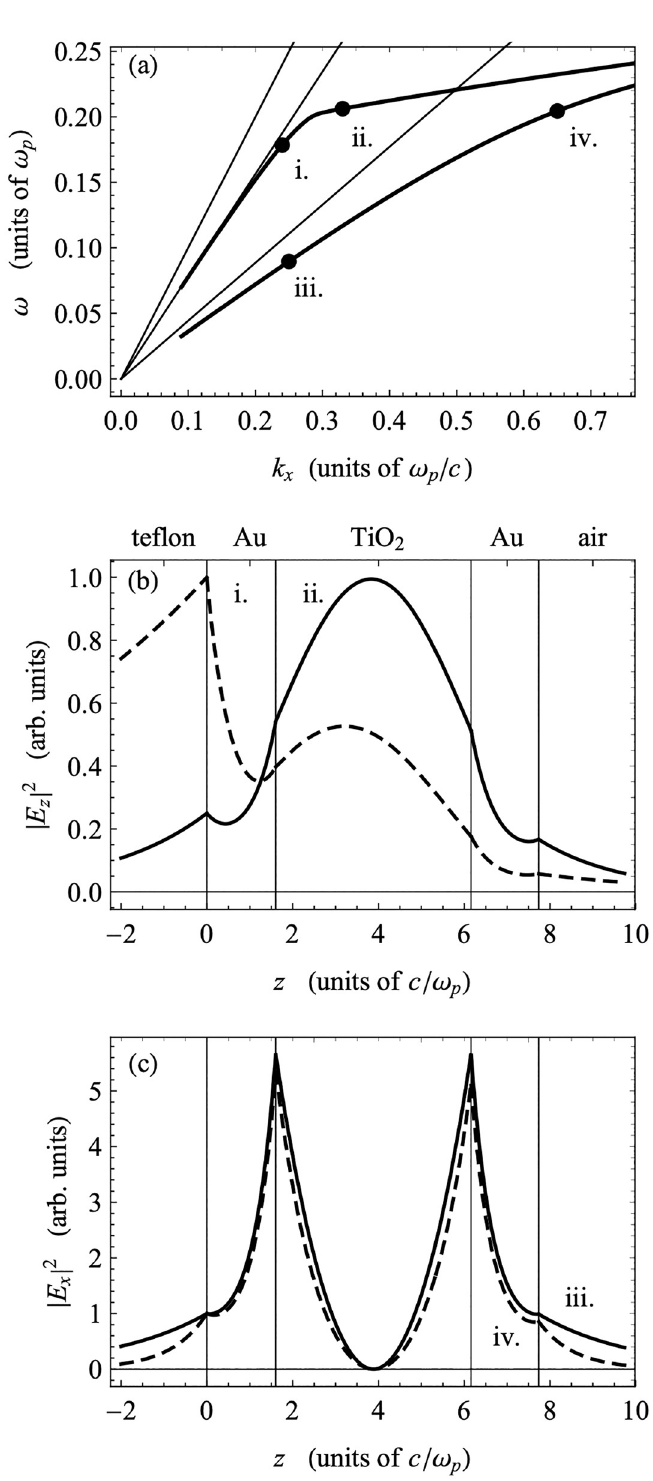
Fig 9. Magnification of lower frequency dispersion region in Fig 6 and electric field amplitudes. a) the lower frequency region of the dispersion displayed in Fig 6; b) electric field amplitude (modulus squared) associated with points i and ii on the dispersion plot; c) electric field amplitude (modulus squared) associated with points iii and iv on the dispersion plot.